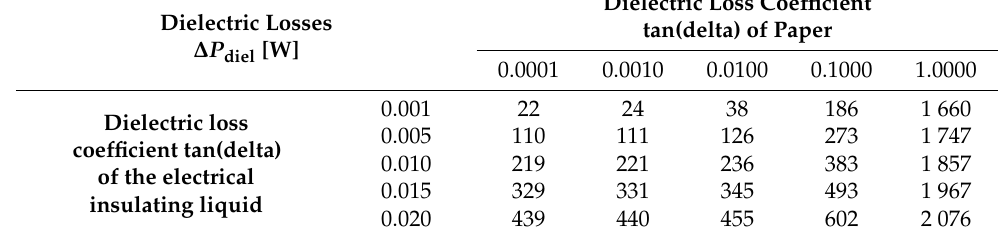
Table 5. Dielectric losses in the selected transformer depending on the dielectric loss coefficient tan(delta) of the paper and the electrical insulating liquid.